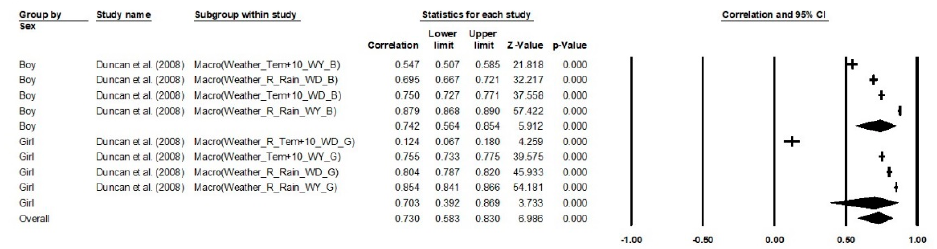
Figure 5. Aggregate correlations on microsystem factors in children and adolescents’ PA. Note. ASP = After school physical activity promotion; ATS = Active transport to school; B = Boy; CIM = Children independent mobility; DAP = During adolescent period; DS = Daily steps; R = Reversed correlation; EO = Environmental opportunities; ES = Extracurricular sport; G = Girl; OE = Outcome experiences; PD = Parent daughter; SE = Self-efficiency; SPE = School physical education promotion; WD = Weekend; WY = Weekday.